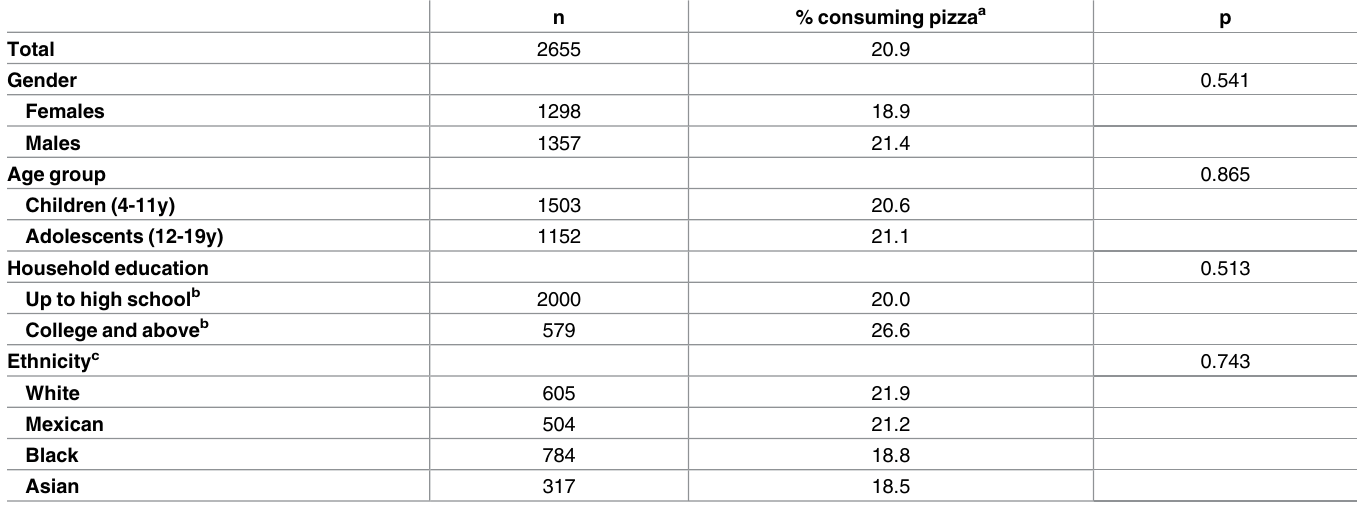
Table 1. Prevalence of pizza consumption in NHANES 2011–12children and adolescents having completed the first 24-hr recall (Day 1), by gen- der, age group, education level, and ethnicity.